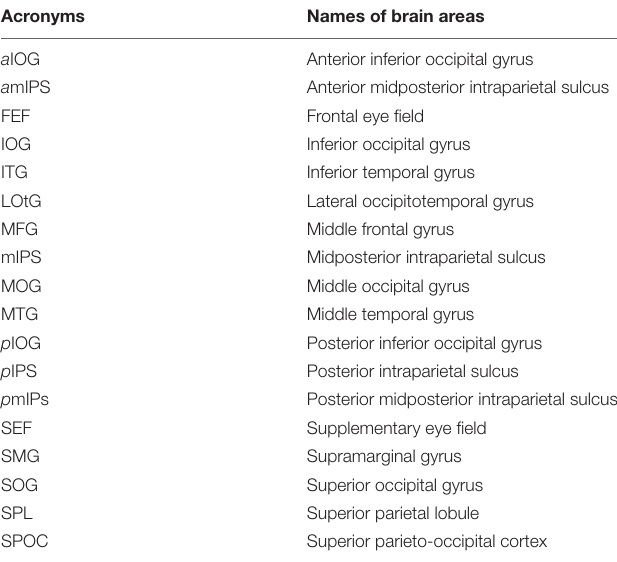
TABLE 1 | Acronyms for brain areas identified by voxelwise